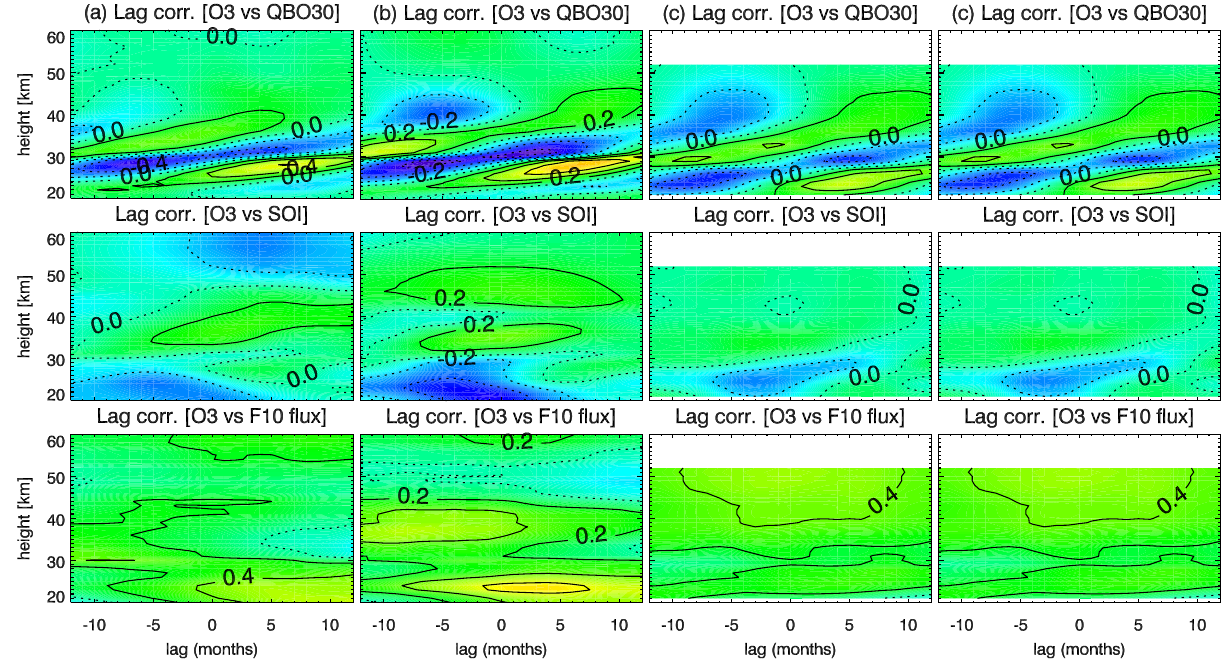
Fig. 4. Lag correlation analysis between tropical ozone anomalies (25 ◦ S–25 ◦ N) and zonal wind (QBO at 30hPa), Southern Oscillation Index (SOI) and F10.7 solar flux from − 12 to +12 months in top, middle and bottom rows, respectively. Column (a) shows the lag-correlation between tropical ozone anomalies from run A E40 and 30hPa QBO, SOI and F10.7 flux for 1979–2005. Column (b) shows results from B EI (1989–2005). Column (c) shows results from SBUV/SAGE (1979–2005, from McLinden et al., 2009). Column (d) shows results from SAGE-based (1979–2005, from Randel and Wu, 2007). Positive correlation are shown with solid lines (green and yellow colours), whereas dashed lines indicate negative correlation (blue-violet